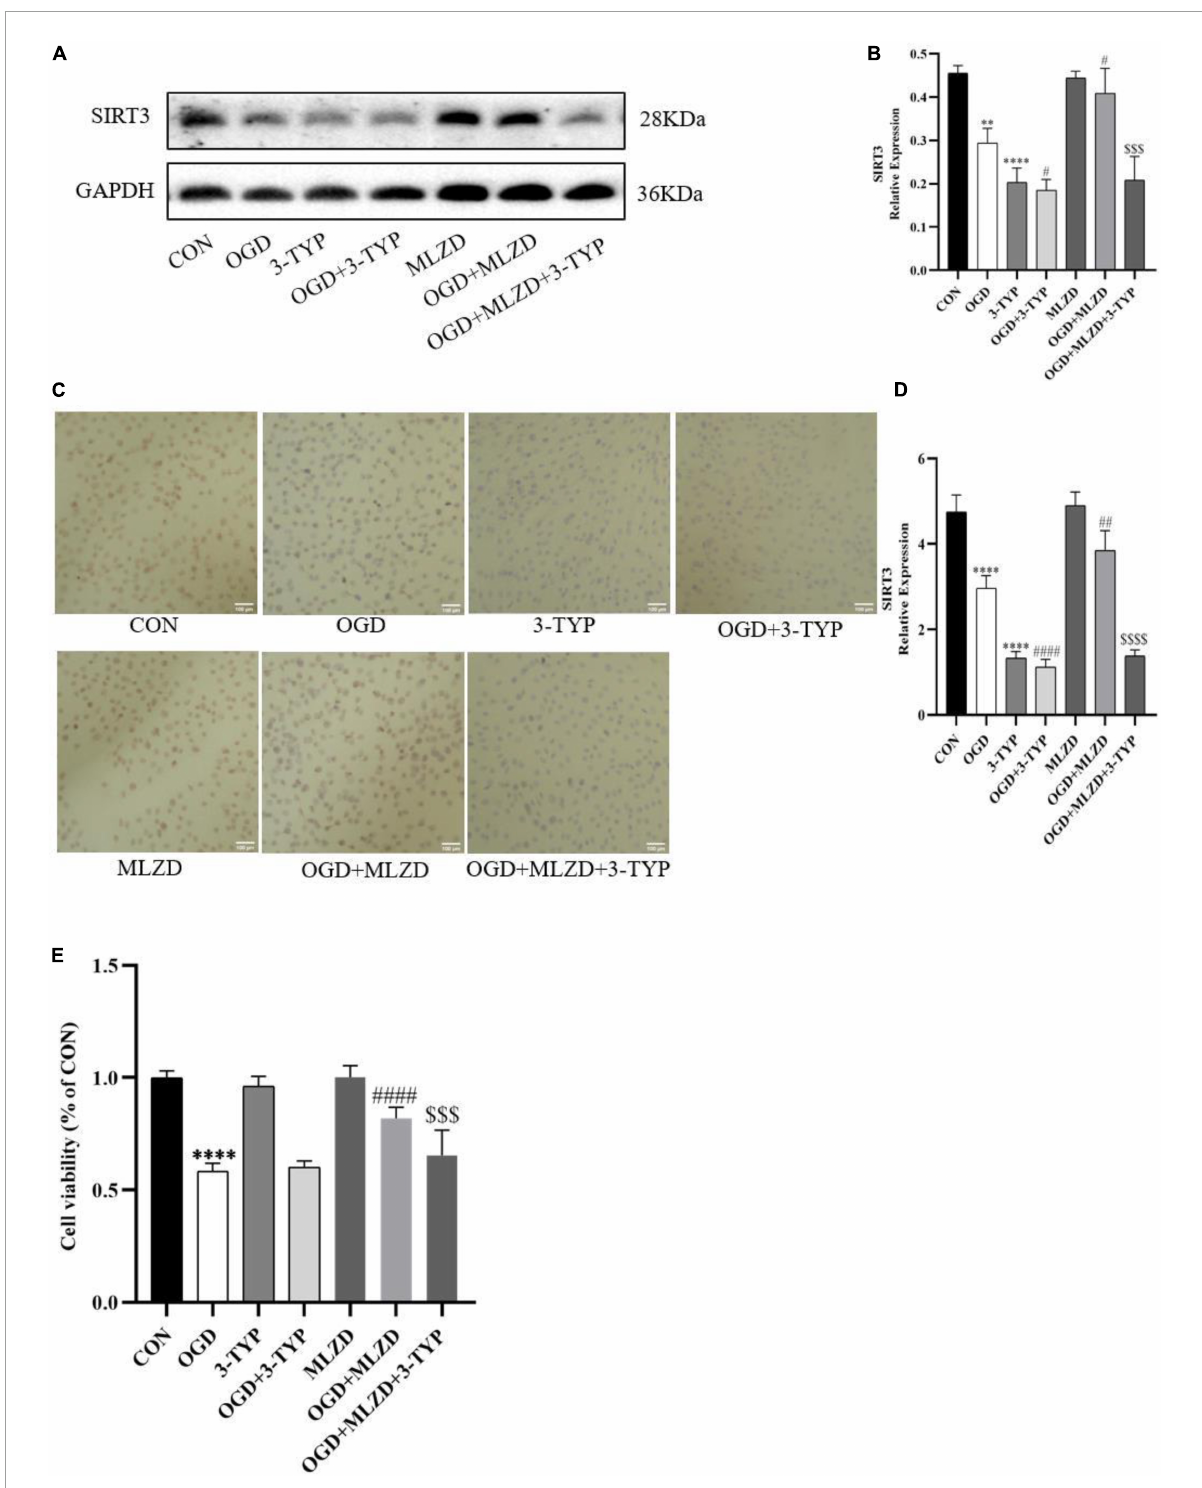
FIGURE8 3-TYP inhibited SIRT3 expression and prevented the cardiomyocyte protective effect of MLZD. (A,B) Relative expression of SIRT3 in cardiomyocytes detected via western blot. The widths of the images have been compressed at a ratio of 1:0.8. (C,D) Immunohistochemical analysis for detecting SIRT3, scale bar = 100 µ m. (E) The cell viability in seven groups evaluated through the CCK-8 test kit. Data are represented as mean ± standard deviation ( x ± s); ∗∗ P < 0.01, ∗∗∗∗ P < 0.0001 vs. CON; # P < 0.05, ## P < 0.01, #### P < 0.0001 vs. OGD; $$$ P < 0.001, $$$$ P < 0.0001, vs.